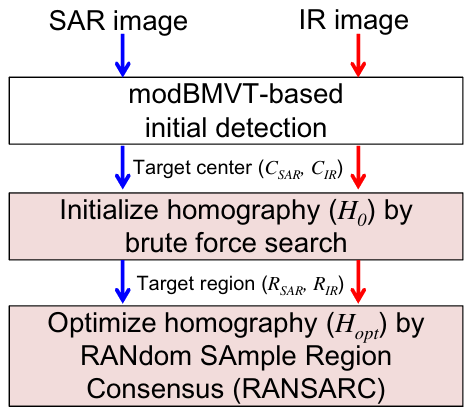
Figure 12. Proposed detection-based SAR/IR registration using RANSARC optimization.